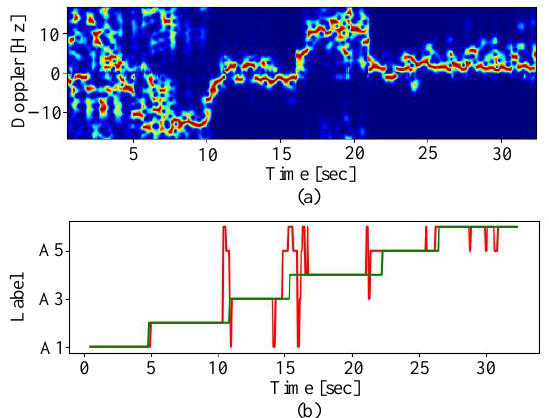
Figure 10. ( a ) The spectrogram of S1 at 1.7 GHz. ( b ) The corresponding recognition result using a trained Uni-LSTM sub-network, where green and red lines represent real and identified labels.